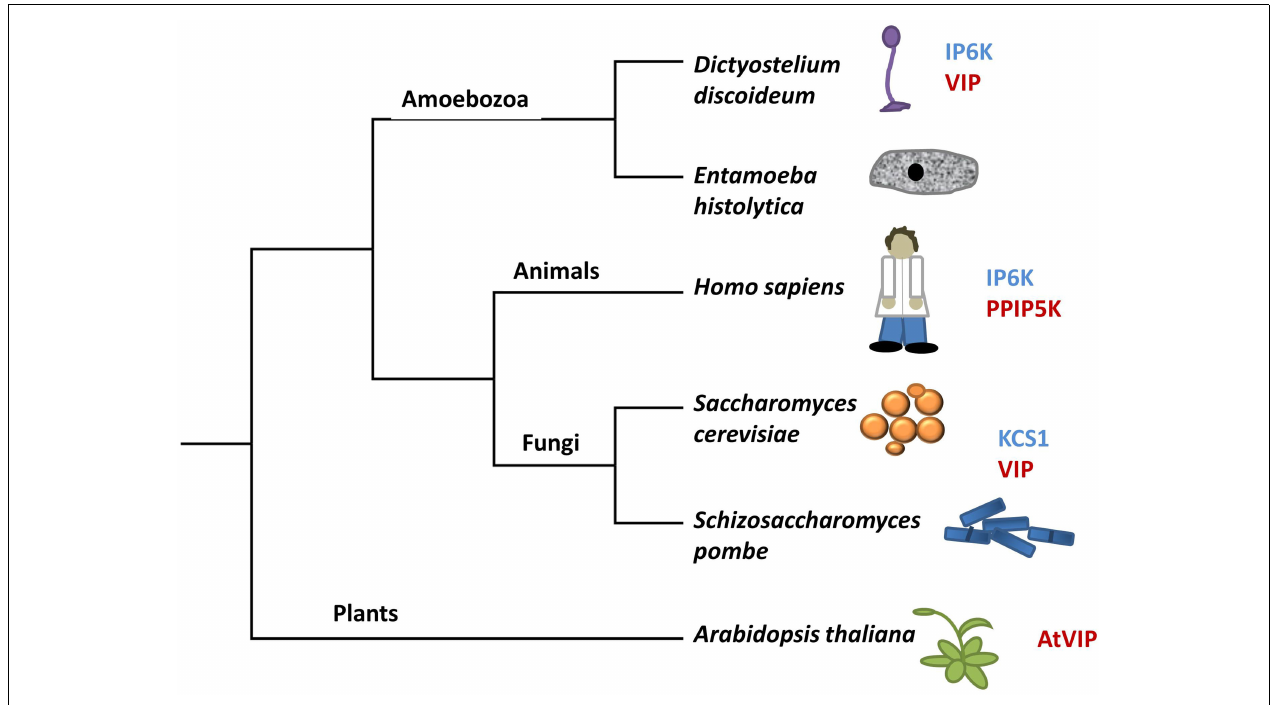
KCS1, whereas genes in red have sequence identity with VIP. The tree depicts evolutionary relationships between groups discussed in the